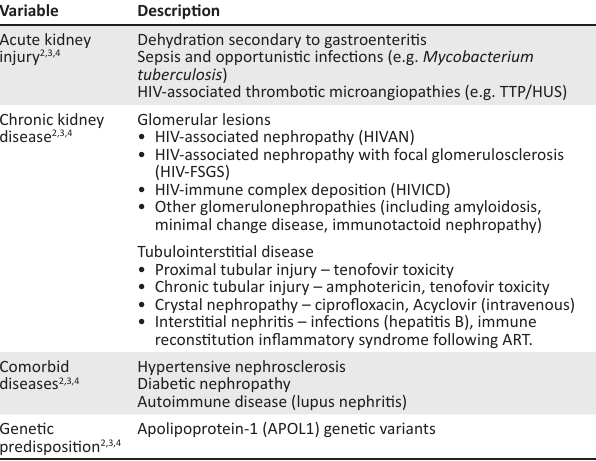
TABLE 1: Causes of renal dysfunction in people living with human immunodeficiency virus. Variable Description Acute kidney injury 2,3,